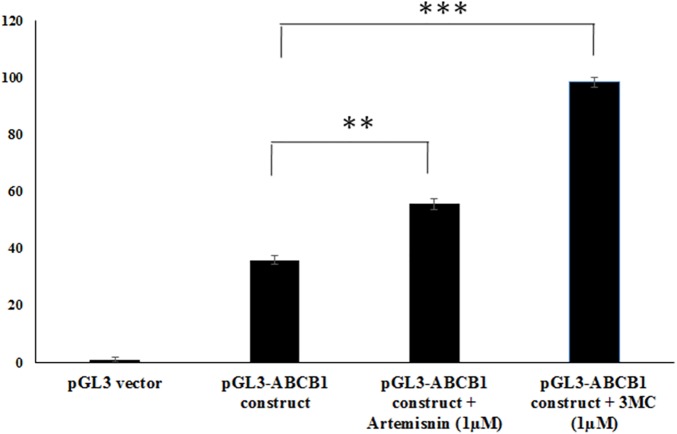
Promoter activity analysis of ABCB1 constructs using luciferase assays.Showing pGL3- ABCB1 construct (contains 949bp DNA fragment) promoter activity results upon artemisinin and 3-methylcholanthrene treatments.